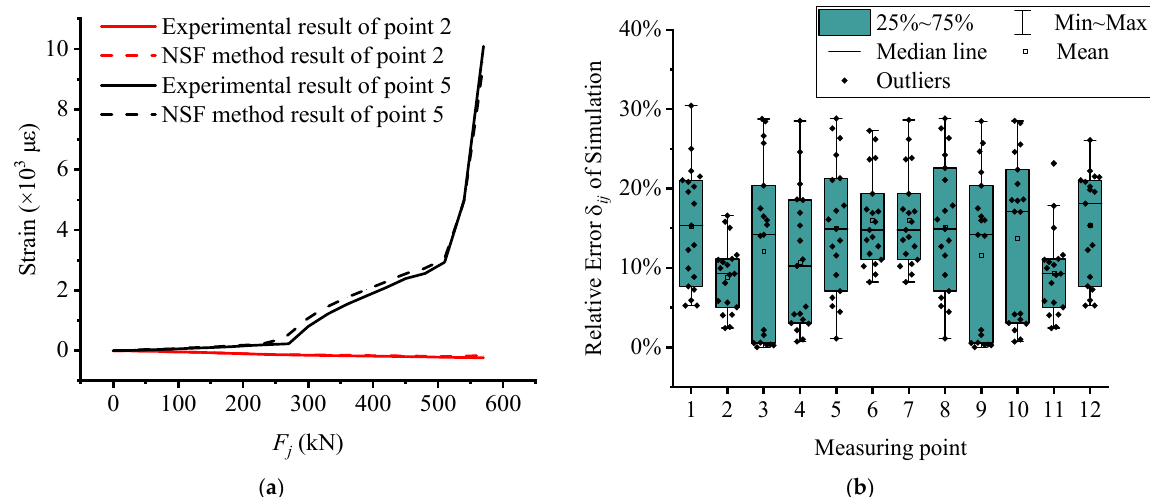
Figure 10. The error analysis of the NSF method: ( a ) comparison between experimental strain and interpolated strain of unbonded No. 4 beam; ( b ) box plot of simulation relative error of unbonded No. 4 beam.